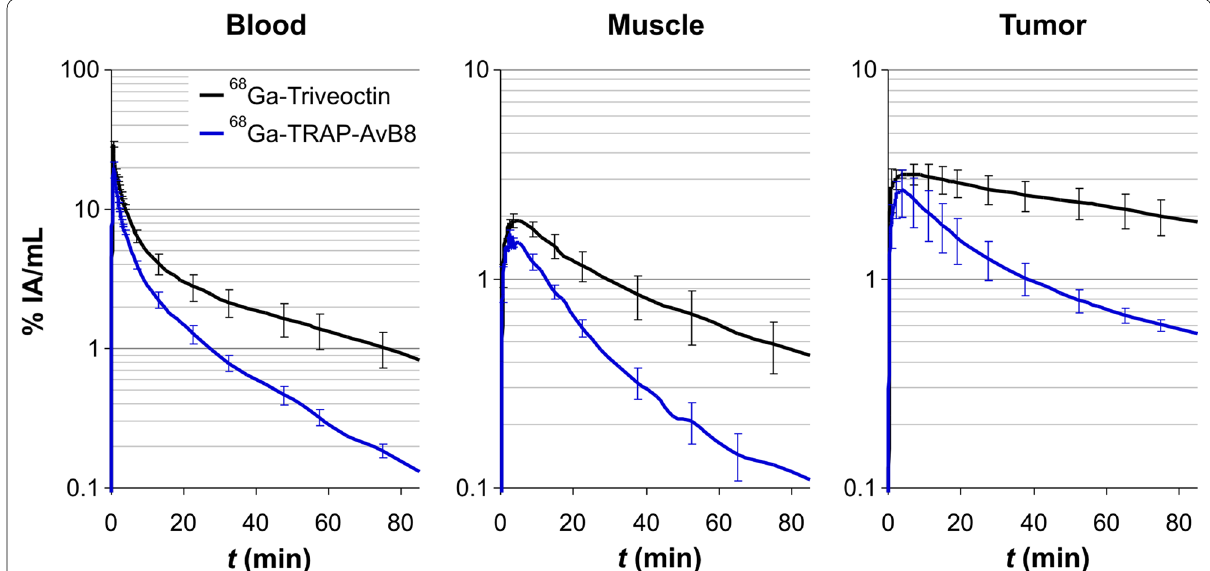
Fig. 2 Kinetics for 68 Ga-Triveoctin (black lines; 11 151 107 pmol, 93 50 MBq/nmol), derived from dynamic PET data in MeWo-xenografted SCID mice ( n ± ±